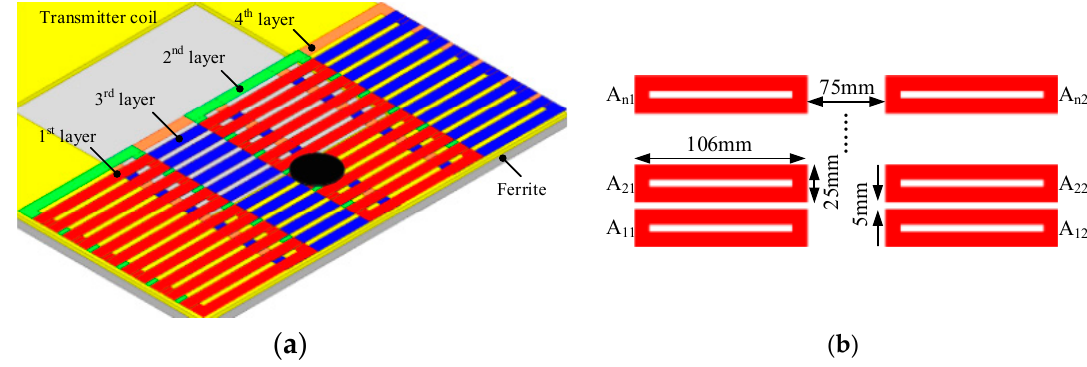
Figure 4. ( a ) Model of a half of the four-layer rectangular layout detection coils in Maxwell. ( b ) The Structural parameters of the first layer detection coils.